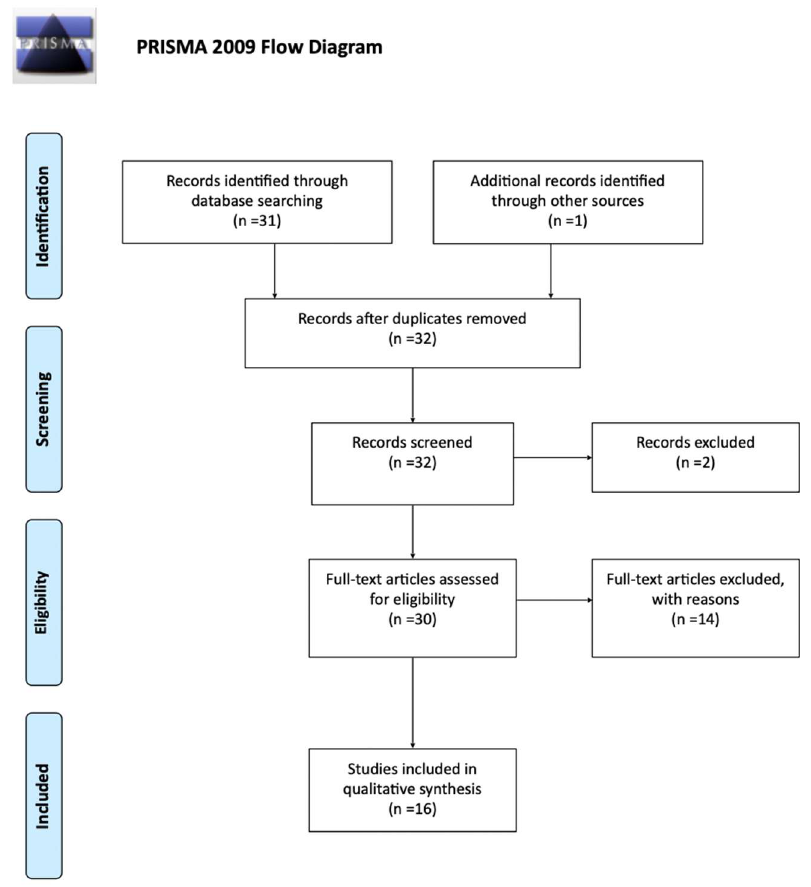
Figure 1. PRISMA flow chart